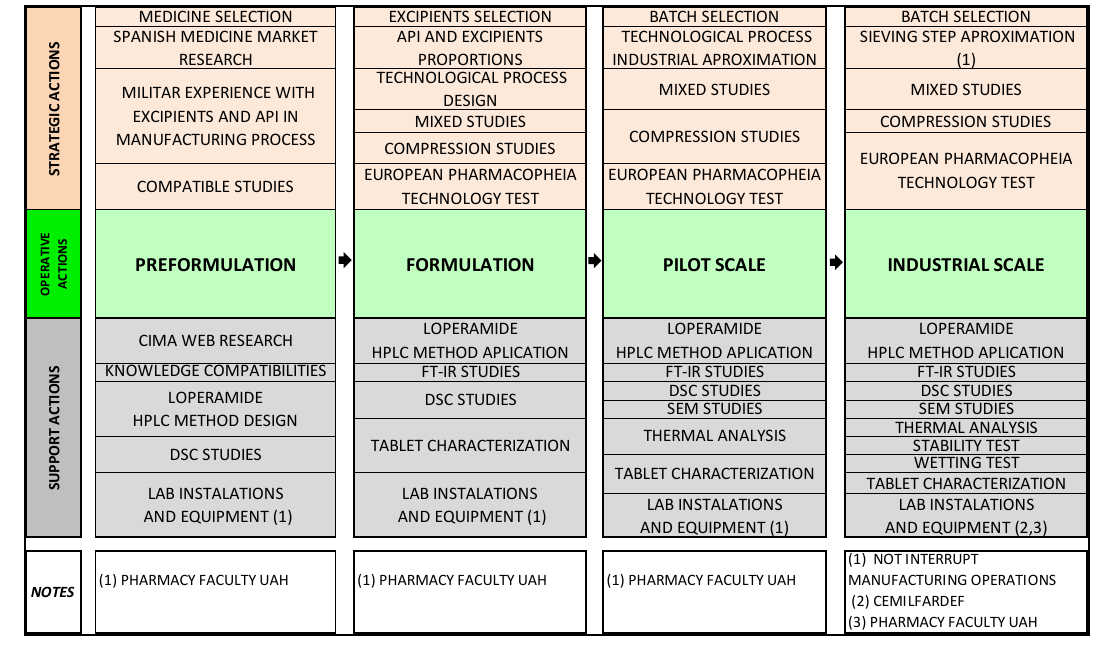
Figure 1. Methods structure of the study.